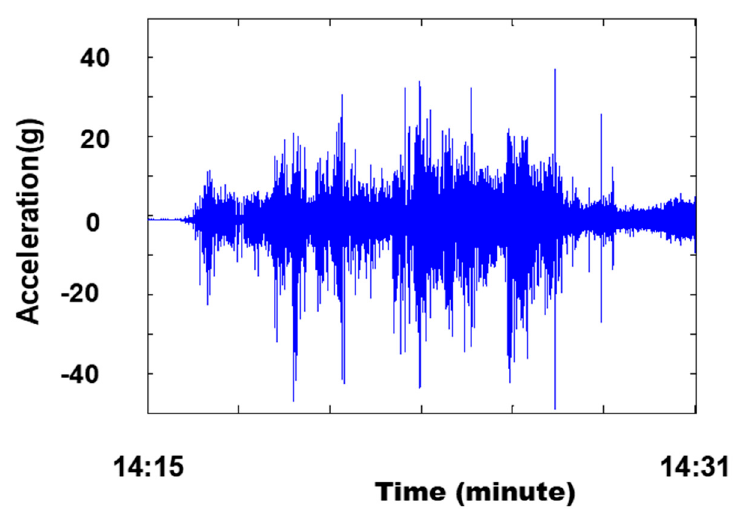
Figure 2. The vibration acceleration on the axle.